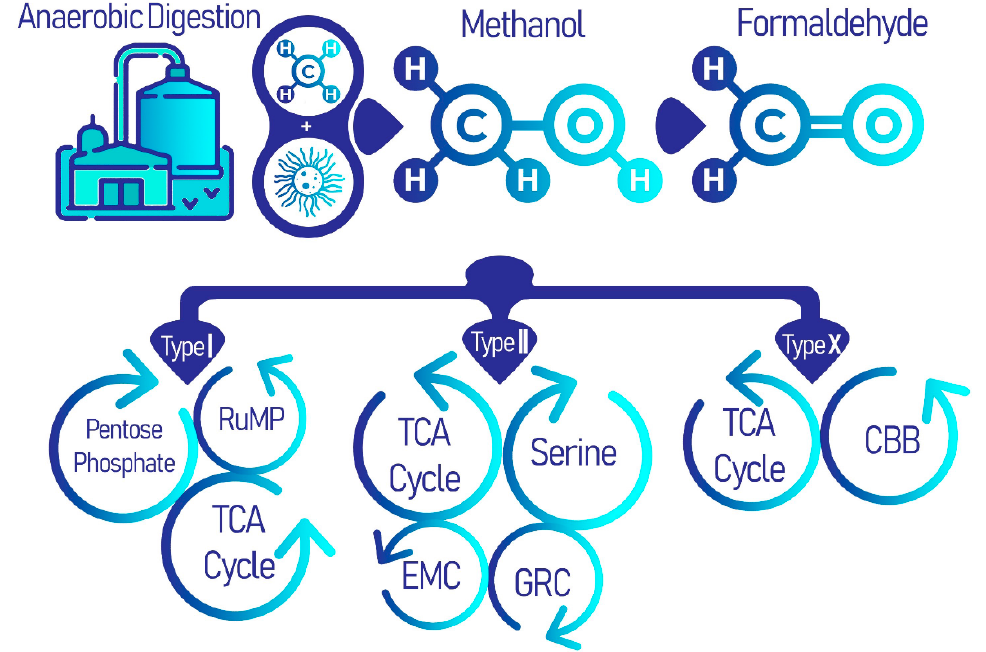
Figure 1. Methanotrophs in anaerobic digestion processes of WWTPs using the common methane oxidation pathway, which branches out for distinct metabolic cycles for each type of methanotrophs: types I, II, and X. It is these distinct secondary metabolic pathways, including the pentose-phosphate pathway (PPP), tricarboxylic acid (TCA) cycle, serine cycle, ethyl malonyl-CoA (EMC) pathway, glyoxylate regeneration cycle (GRC) and the Calvin-Benson-Bassham (CBB) cycle, that produce a diversity of useful biomolecules.